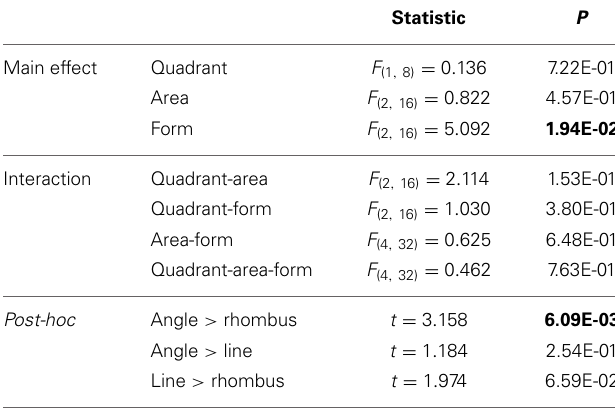
Table 2 | Results of Three-Way ANOVA comparisons of Blood-oxygen-level dependent intensities associated with quadrants, areas and forms across nine